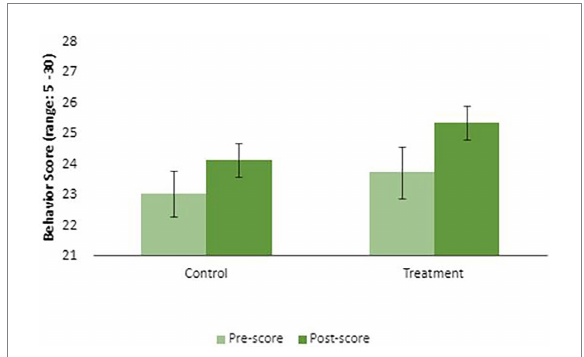
FIGURE 1 Pre versus post-test behaviour scores for student in the control ( n = 201) and treatment ( n = 422) groups. Error bars represent a 95% confidence